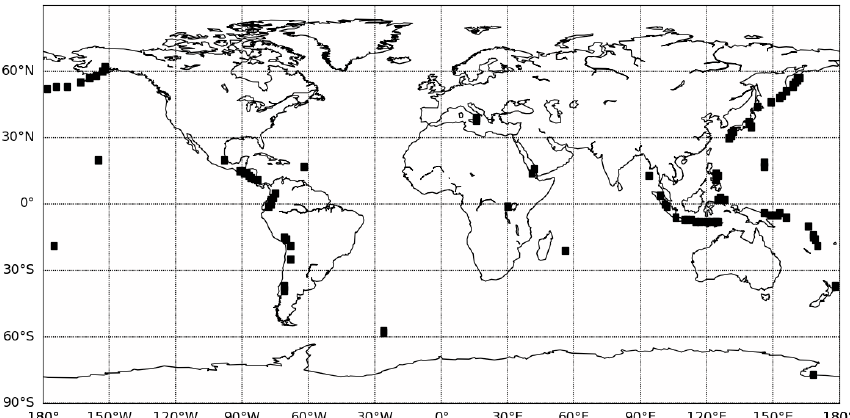
Figure 3. Location of the selected areas where OMI SO 2 total column are selected for the validation. They correspond to nine MOCAGE grid points around each volcano from Carn et al. (2016,